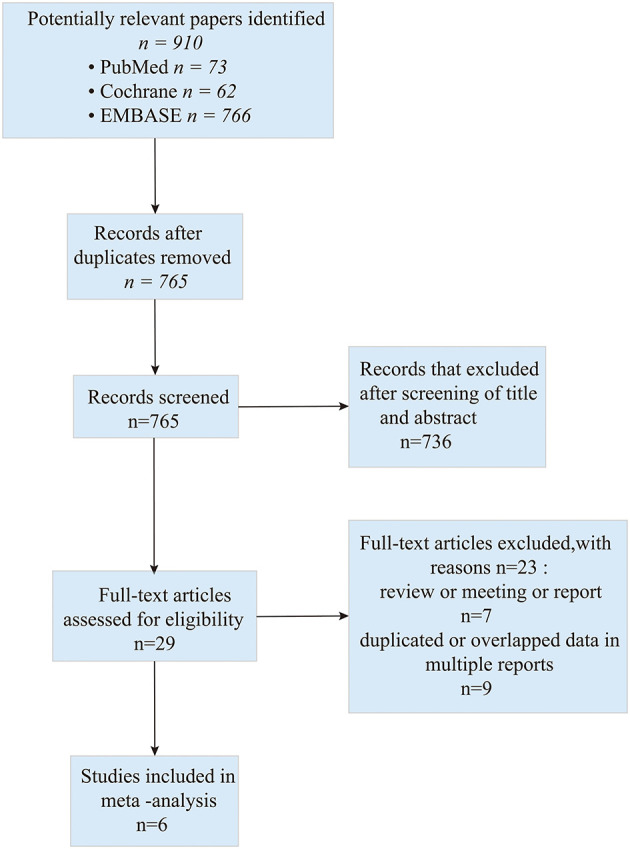
Flow diagram of study selection based on the PRISMA statement.